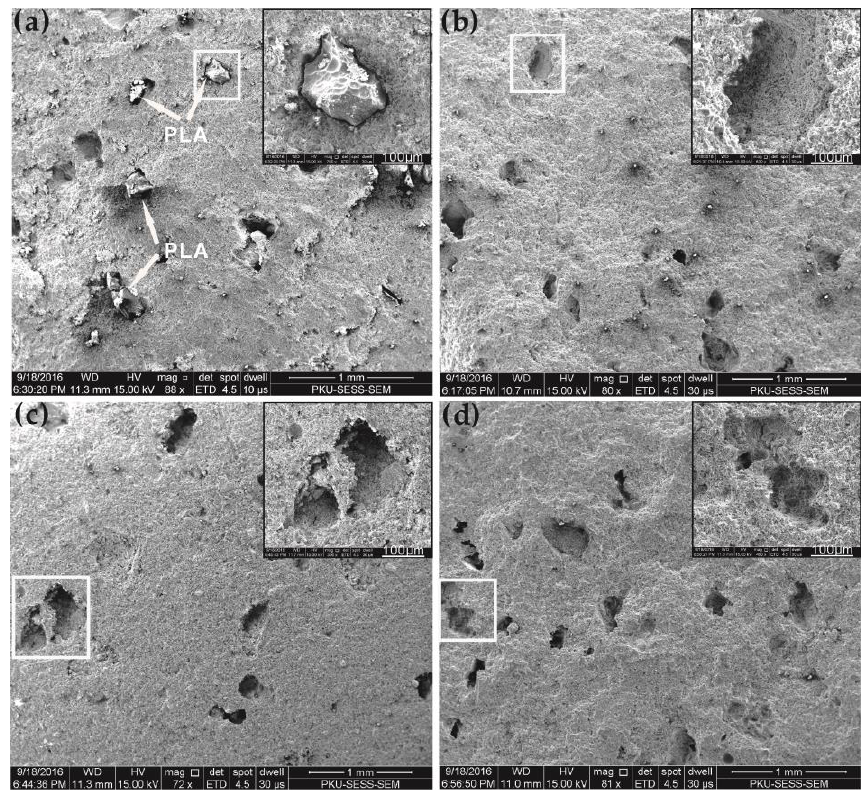
Figure 12. SEM images of smaller magnification of the SDTSM with 2% PLA after different periods: ( a ) 85 °C-cured; ( b ) 200 °C-heated; ( c ) immersed in water for 2 h and ( d ) immersed in water for 24 h.